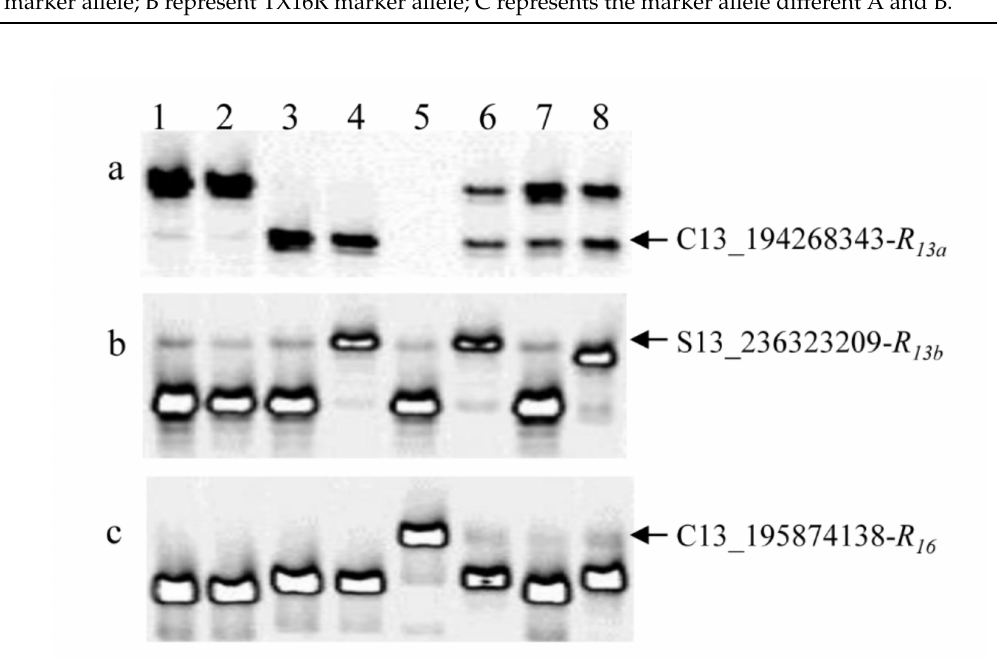
Figure 5. The polymerase chain reaction (PCR) amplification patterns of the single nucleotide polymorphism (SNP) markers in the eight sunflower lines. ( a ) SNP C13_194268343 linked to R 13a , the arrow indicates the amplified band corresponding to C13_194268343- R 13a marker allele, R 13a shares the PCR pattern of the marker allele with R 13b . ( b ) SNP S13_236323209 linked to R 13b , the arrow indicates the amplified band corresponding to S13_236323209- R 13b marker allele, R 13b shares the PCR pattern of the marker allele with R 4 . ( c ) SNP C13_195874138 linked to R 16 can distinguish R 16 from all genes in the cluster, the arrow indicates the amplified band corresponding to C13_195874138- R